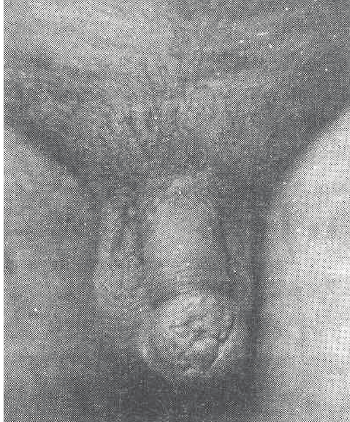
Figure 1: Showing tuberculosis of the glans penis. Reproduced from [5] D. K. Pal, A. K. Kundu, S. Chakraborty, S. Das, “Tuberculosis of Penis: Report of Two Cases,” Ind. J Tub vol. 43; pp. 203-204, 1996. Copy right Indian Journal of Tuberculosis. Reproduced